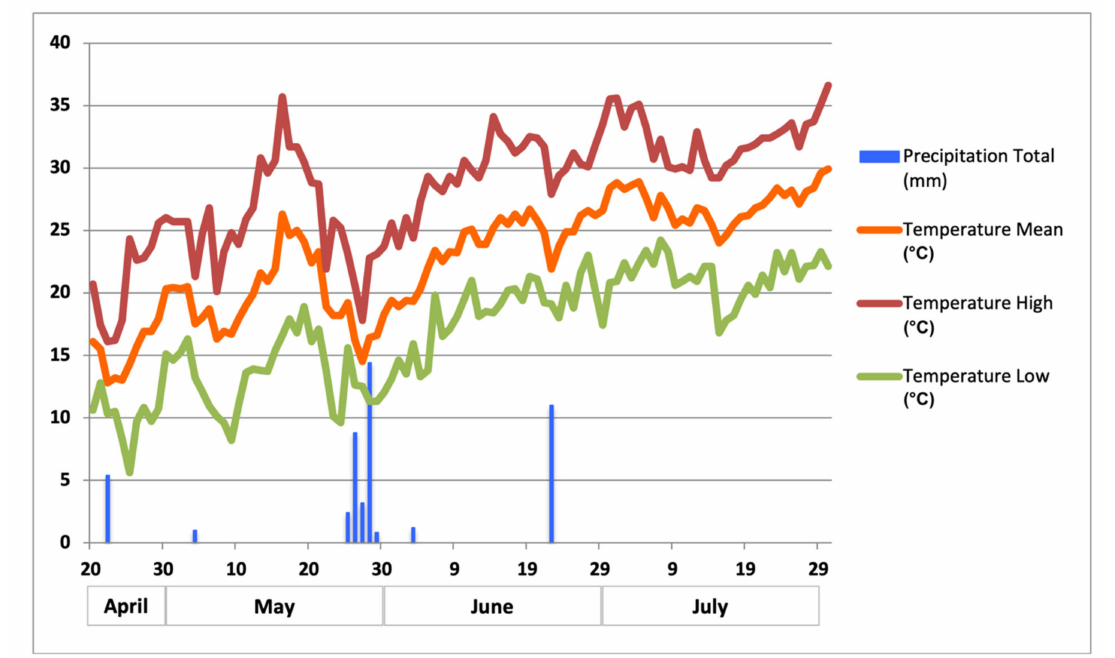
Figure 1. Daily mean, high and low temperature, and precipitation at Oropos during experimental